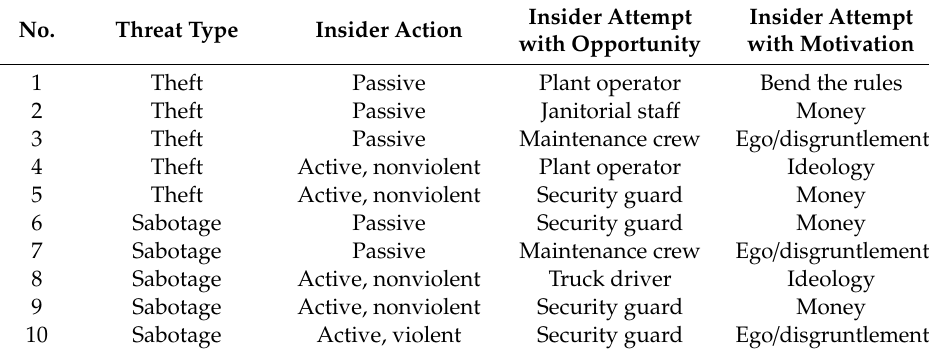
Table 1. Ten insider threat